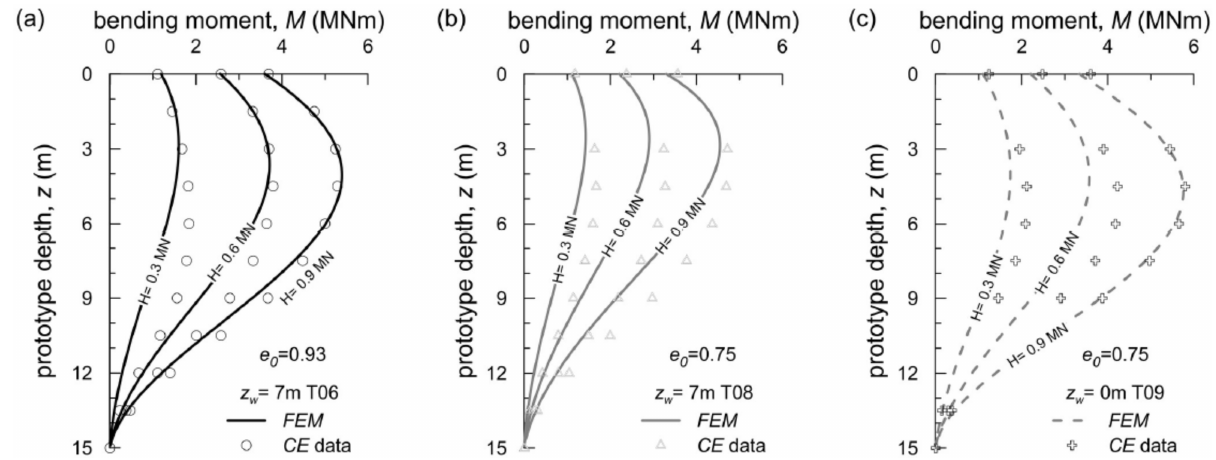
Figure 7. Distribution of bending moment measured and predicted: ( a ) T06 (LU); ( b ) T08 (DU); ( c ) T09